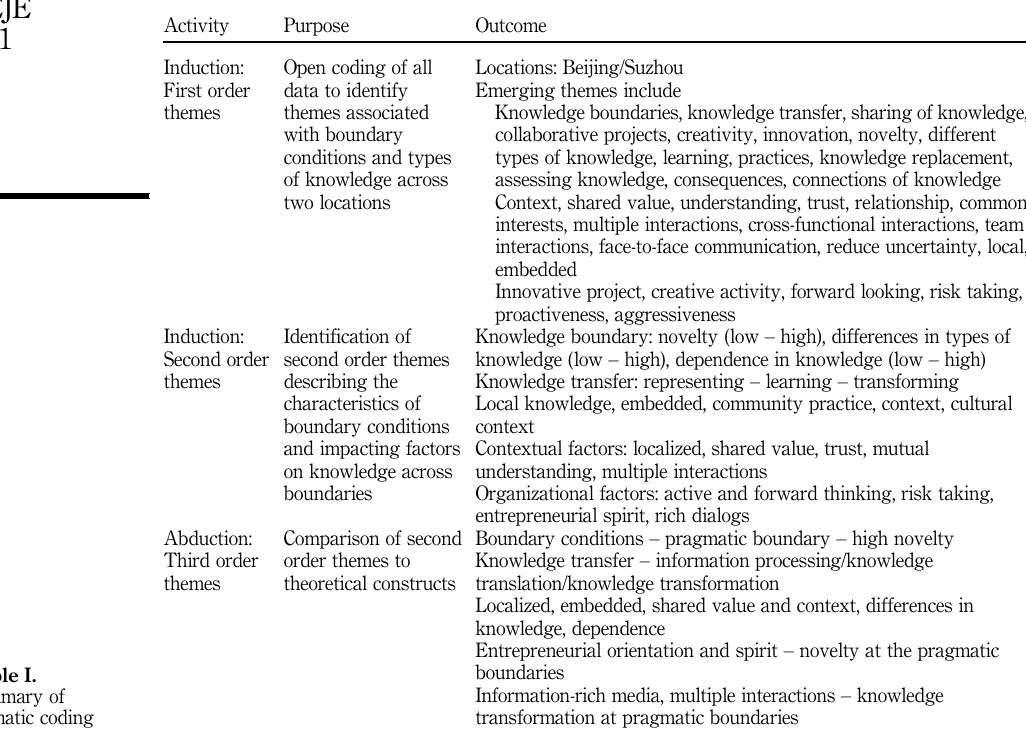
Table I. Summary of thematic